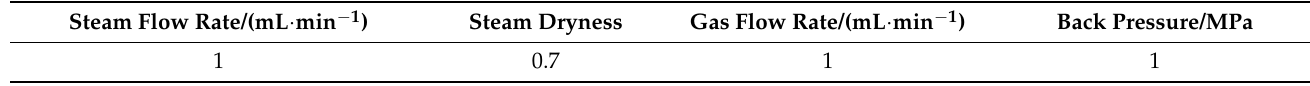
Table 3. Injection parameters of various displacement experiments.